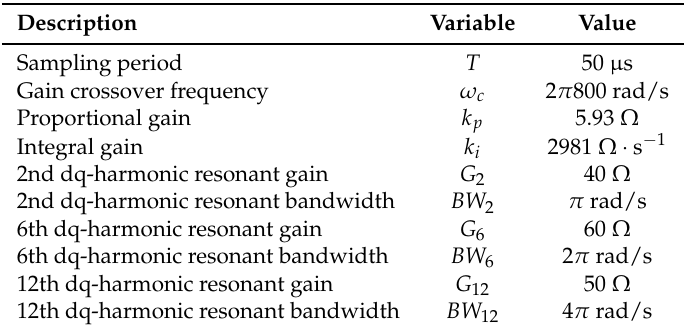
Table 3. PI and PR control parameters.